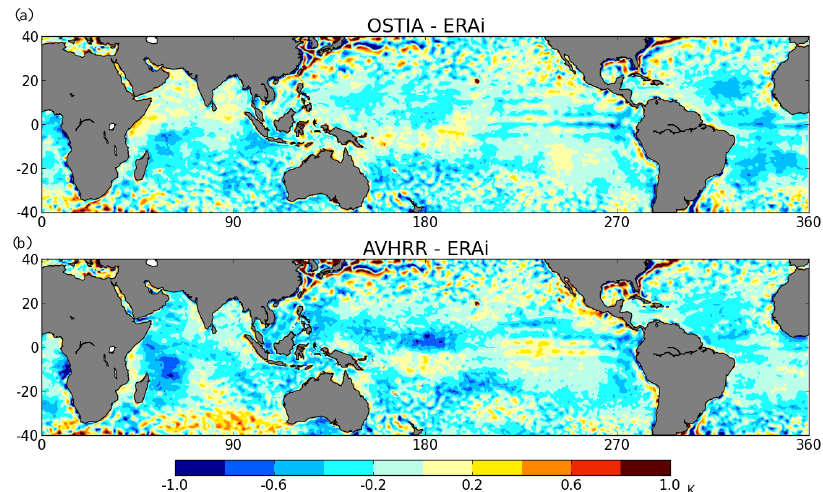
Fig. 1. (a) Difference between OSTIA and ERAi SST (in K) averaged over the winter (December to March) 1992–1993 in the Tropics. (b) Same as (a) for AVHRR SST.